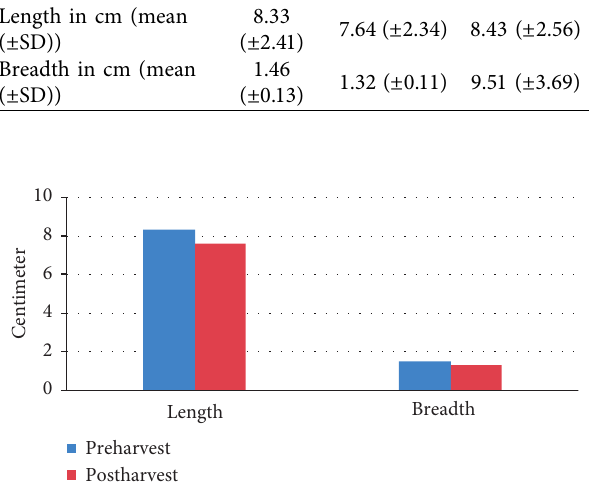
Figure 2: Preharvest vs. postharvest